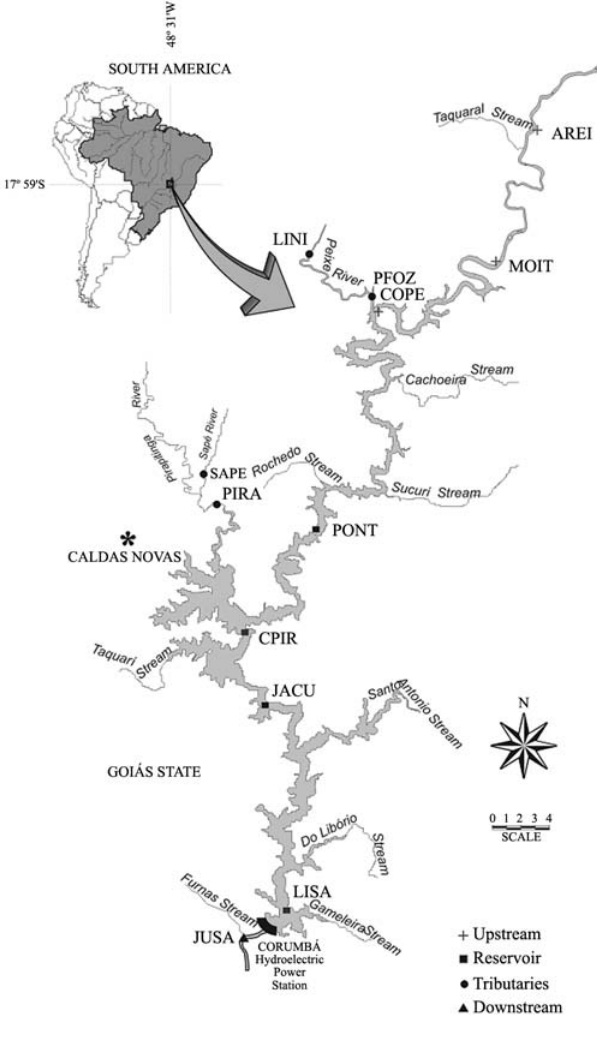
Fig. 1. Location of the sampling sites in the area of Corumbá